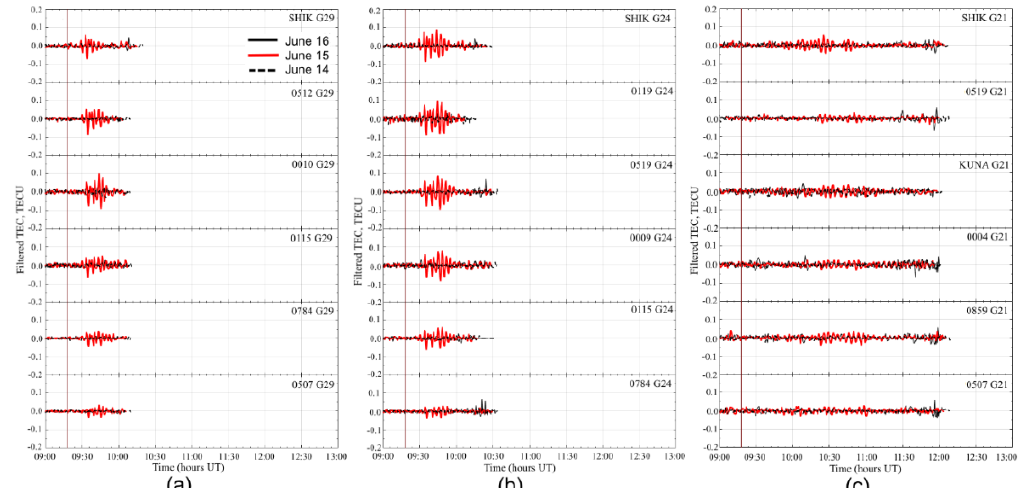
Figure 11. Examples of covolcanic ionospheric disturbances initiated by the volcanic explosion occurred at 09:18 UT on 15 June 2009. Filtered vertical TEC series are plotted for three consecutive days (14–16 June). ( a – c ), The satellite G29, G24 and G21 filtered vertical TEC series accordingly. All other notations are identical to the appropriate ones adopted in Figure 3.